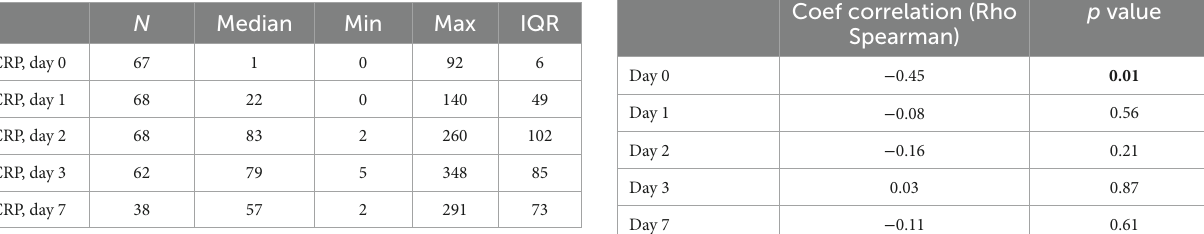
TABLE 8 Correlation of H-FABP with CRP.